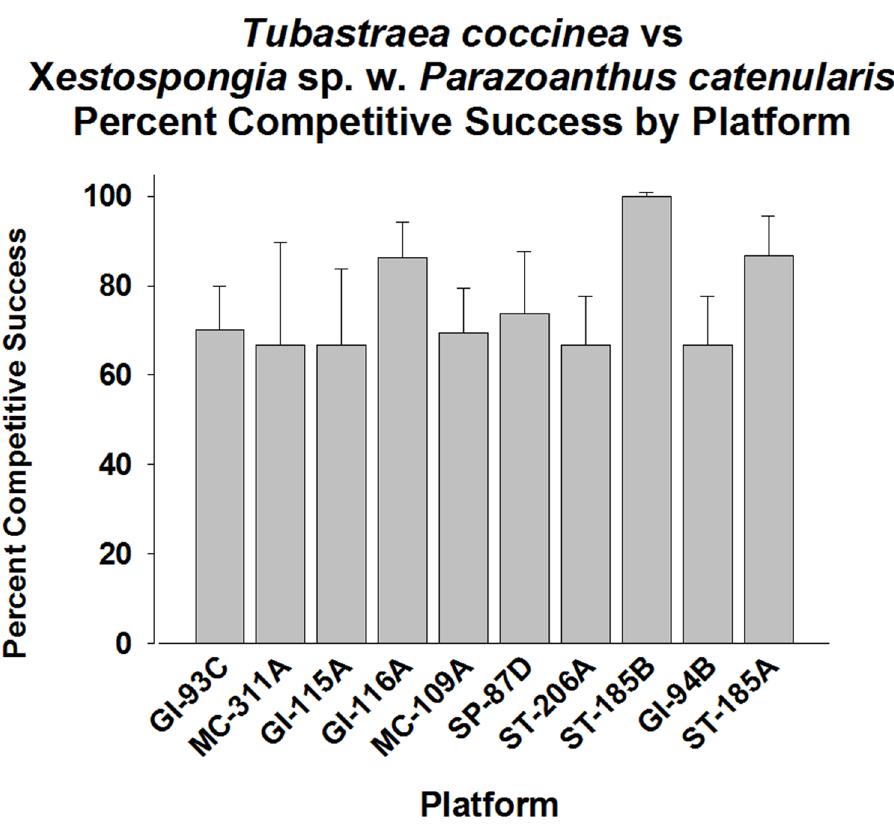
Fig 7. Percent of success in competition for space between Tubastraea coccinea vs. Xestospongia sp. (with commensal zoanthids Parazoanthus catenularis ), by platform. Mean plus 95% confidence limits shown. Range of number of interactions per platform (n): 19 – 74. See Fig 2 legend for additional details. Overall competitive success significantly higher than the expected 50% (p < 0.001, Fisher ’ s Exact Test). Also, almost all platforms exhibited significantly high frequencies of competitive success (p < 0.05 – 0.001, Goodness of Fit Test, G-statistic). Only coral populations on MC-311A and GI-115A exhibited non-significant levels of competitive success ( < 50% frequency of success, p >